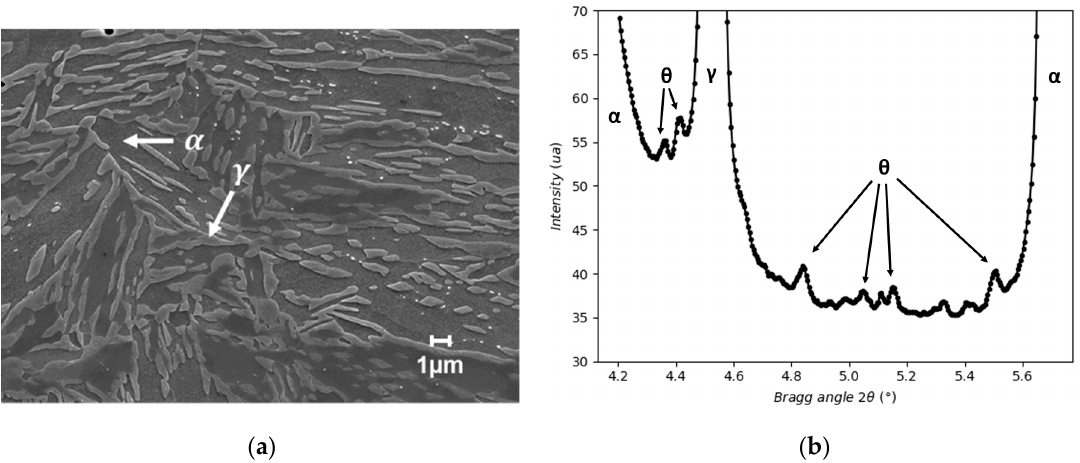
Figure 1. ( a ) Microstructure observation (SEM micrographs after Nital etching) of the fibrous microstructure (austenite in light grey; ferrite in dark grey). ( b ) 1D diffractogram obtained by high-energy x-ray diffraction (HEXRD) before deformation in the 4.1–5.7° ranges highlighting minor cementite θ diffraction peaks. For comparison, in this diffractogram, the most intense peak is the {111} α (situated at 4.02° and not observed in the Figure) and has an intensity of 7000.